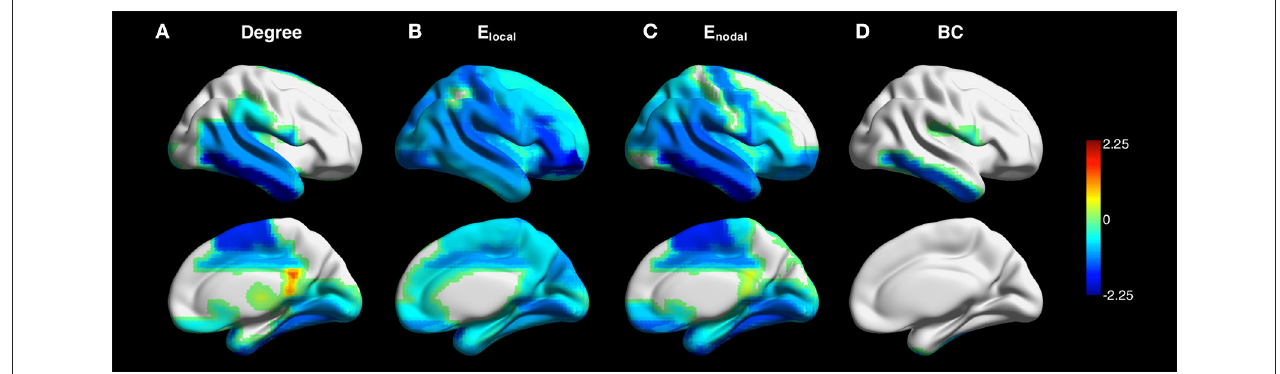
FIGURE 4 | Z -maps of degree (A) , local efficiency E local (B) , nodal efficiency E nodal (C) , and betweenness centrality (BC) (D) in the contralateral hemispheres averaged across all patients (connectivity sparsity = 40%). The maps of the patients with right-sided disease were left-right flipped to create the averaged maps. One-sample t -test with false discovery rate correction showed that negative z -scores of degree were primarily observed in the supplementary motor, fusiform and temporal cortices. Negative z-scores were found across the brain for E local and E nodal . The z -scores of betweenness centrality were negative in the Rolandic operculum and inferior temporal